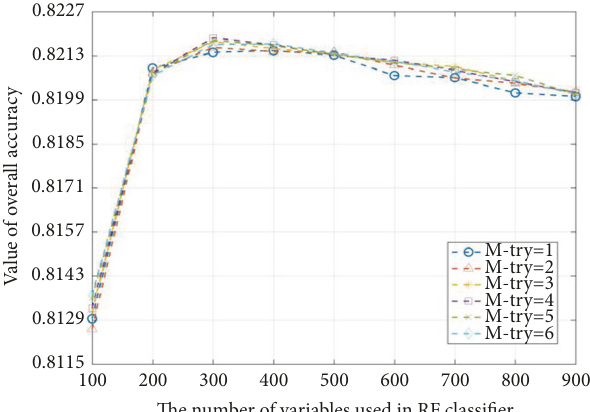
Figure 10: The tendencies of overall accuracy when the N tree and M try are setting different values for AVIRIS.